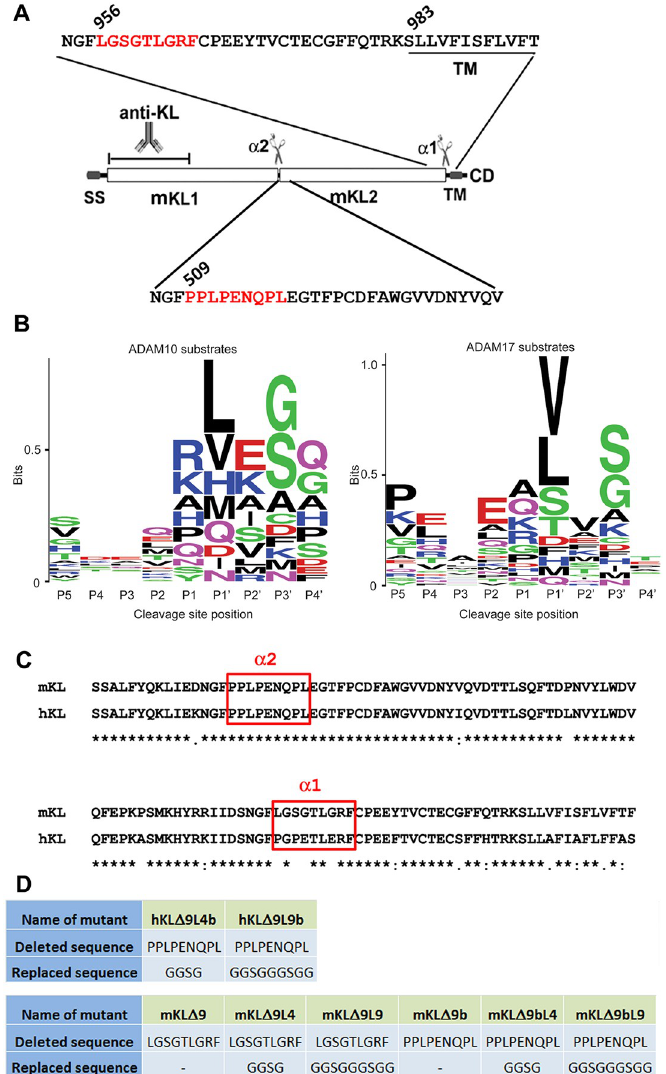
Fig 1. Predicted ADAM10 and ADAM17 cleavage sites in the Klotho protein. A) Diagram of the mouse Klotho protein structure with an enlarged view of the two potential cleavage sites. The nine amino acids that were deleted to form the mutants are marked in a red box. B) Representation of highly conserved residues found at cleavage sites in 34 known ADAM10 and ADAM17 substrate proteins [30] were compiled and used to generate a sequence logo with the program WebLogo 3.0. Logos represent preferred amino acid residues for each primed and unprimed position. The height of the letter is proportional to the log of its frequency in the sequence alignment. C) Alignment of mouse Klotho and human Klotho sheddases recognition sites. The two cleavage sites (alpha1 and alpha2) are marked in red boxes. D) Mutants used in this study. The two cleavage sites sequence and the replaced linker sequence are listed.